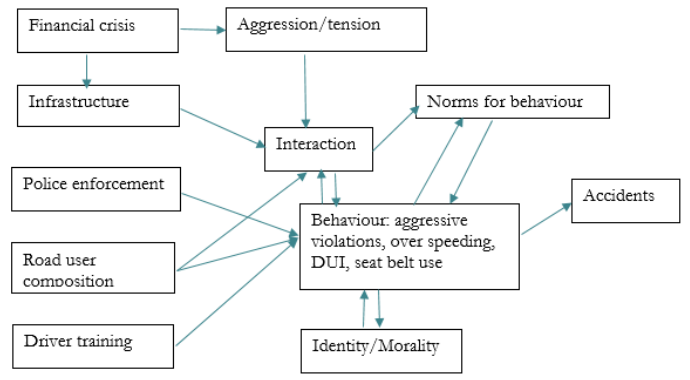
Figure 1. Illustration of possible relationships that should be examined in future research, based on the data in the present study.